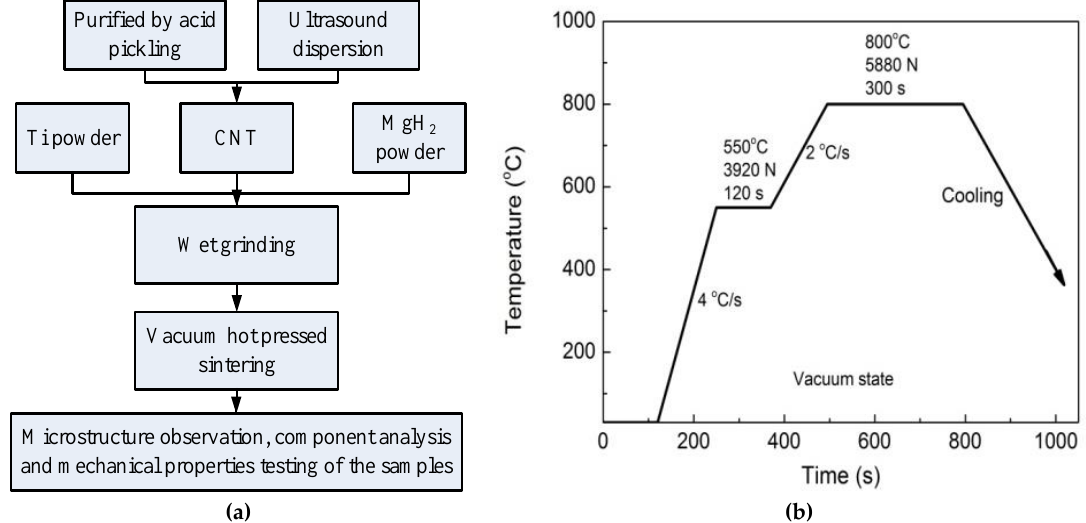
Figure 1. ( a ) The process flow chart and ( b ) the sintering process of the composites.